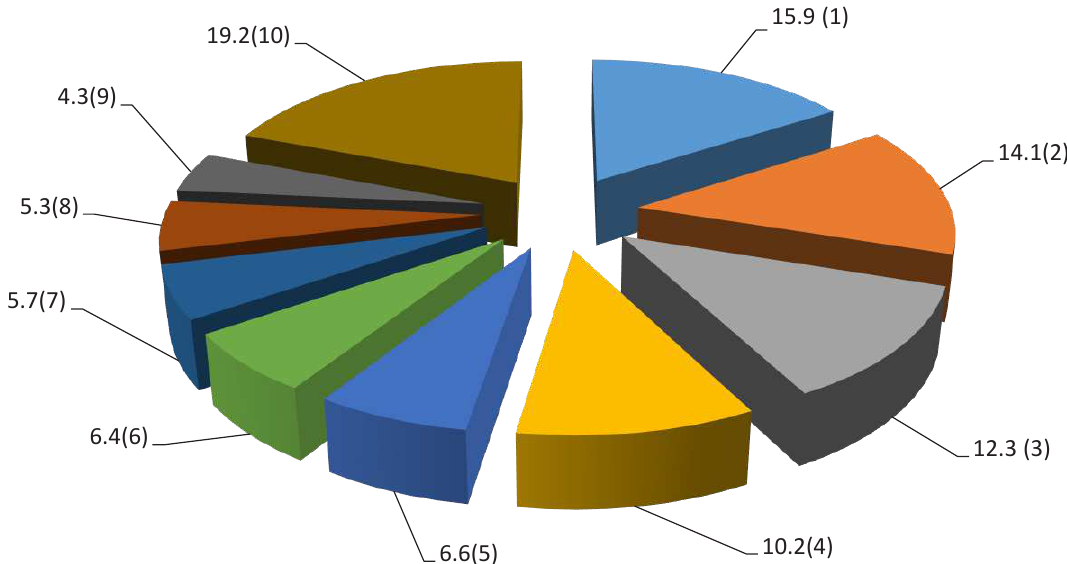
Figure 3. GDP structure according to economic sectors in